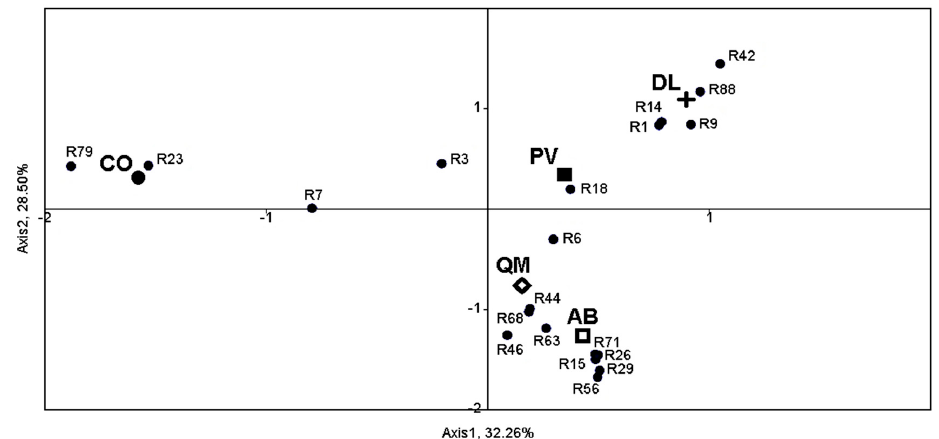
Figure 3. Correspondence analysis of the 20 main S . cerevisiae strains according to SIMPER in Galician organic wineries: biplot of the first two axes.